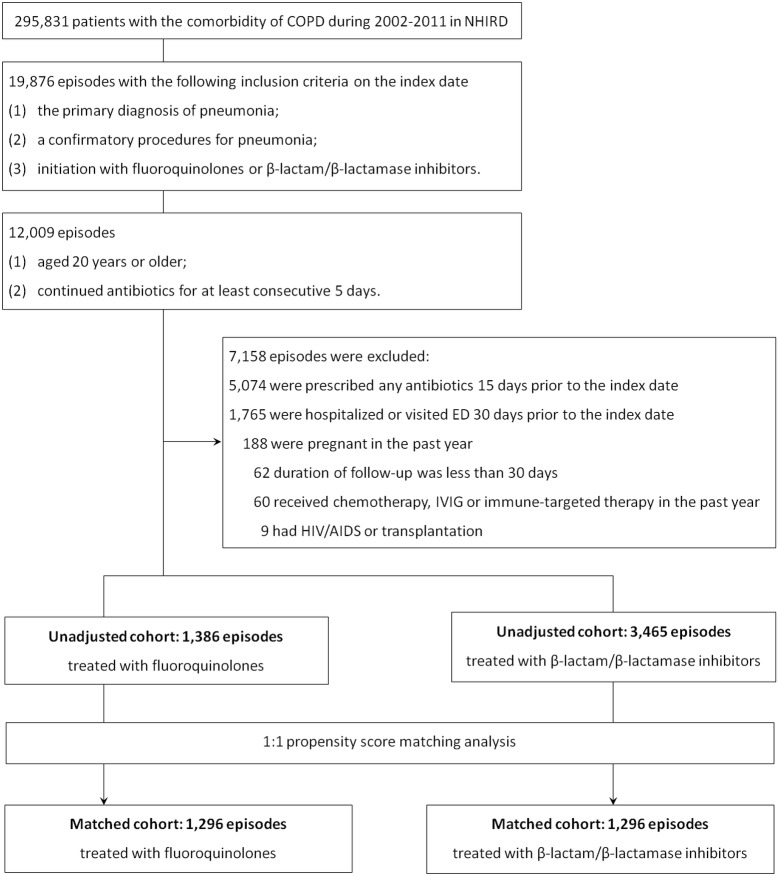
Flow diagram of patient selection.
Abbreviations: COPD, chronic obstructive pulmonary disease; ED, emergency department; IVIG, intravenous immunoglobulin; NHIRD, National Health Insurance Research Database.